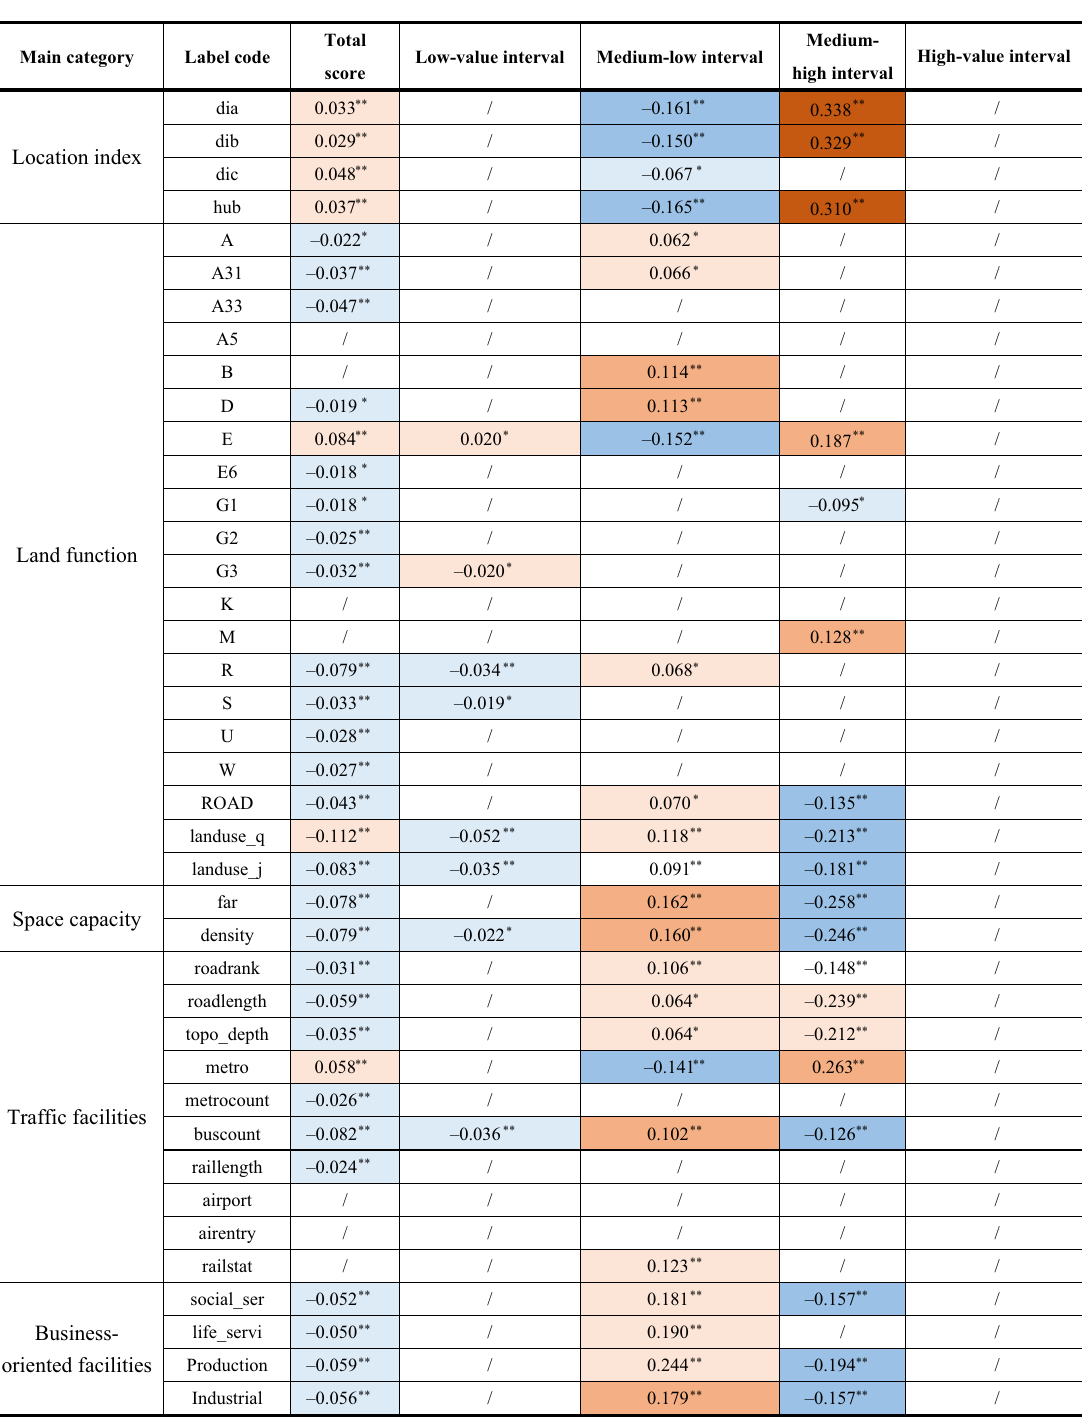
Table 4. Correlation coefficients between average percentage error of classified agglomeration degree and built environmental indicators. Source Author